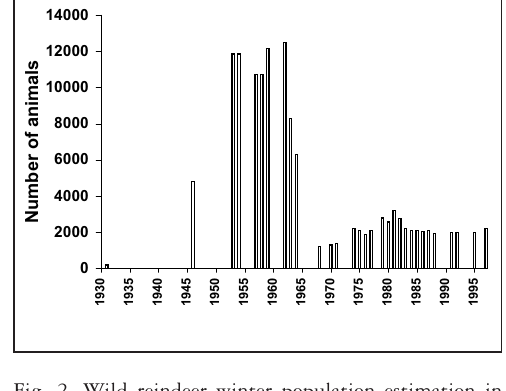
Fig. 2. Wild reindeer winter population estimation in the Snøhetta range, based on Holaker (pers. comm., data for the 1930s), official statistics, and Jordhøy et al.